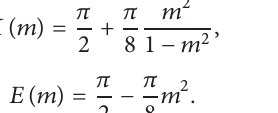
Figure 5: Circuit schematic of the inductive